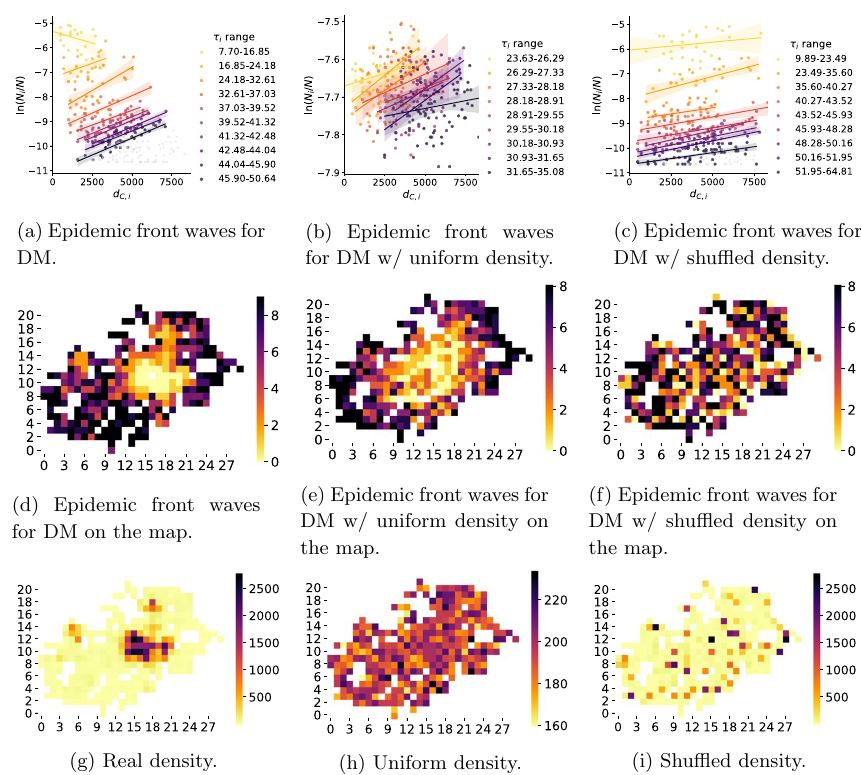
Fig. 5 Epidemic front waves, characterized in terms of their population and centrality ( a – c ), and shown on the map of Viterbo ( d – f ), together with the corresponding population density ( g – i